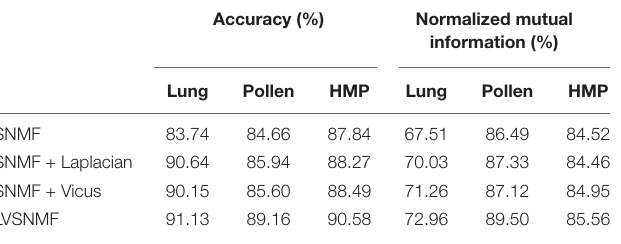
TABLE 2 | The best performance in three real datasets.